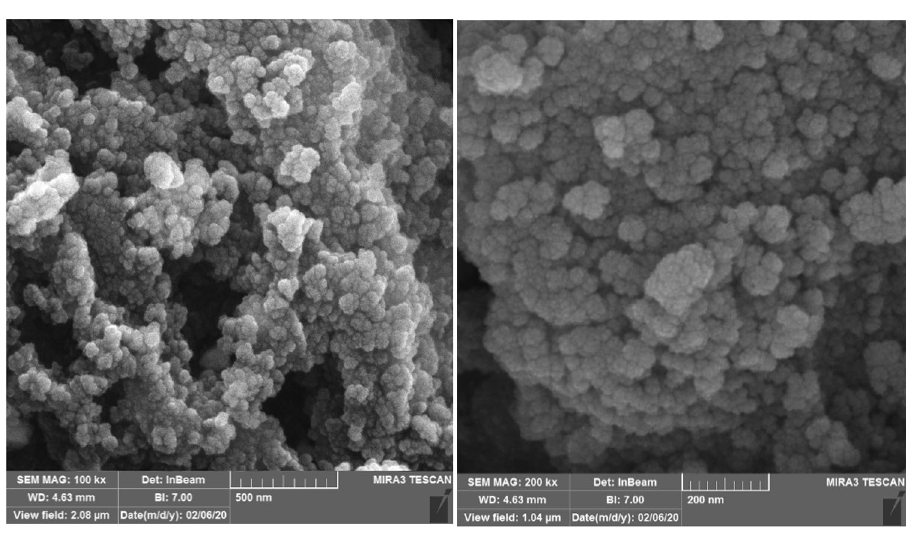
Figure 2. SEM images of Fe 3 O 4 -PTMS-NAS@Cu